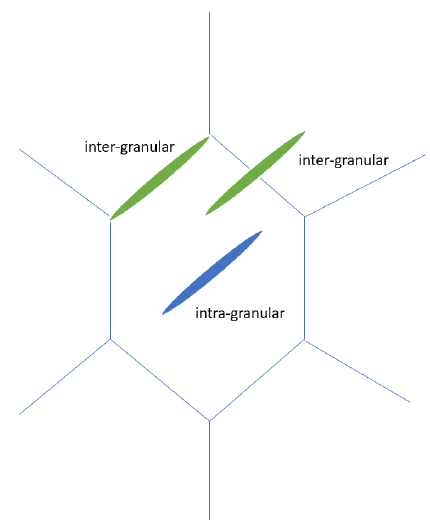
Figure 1. Illustrations of inter-granular (green) and intra-granular (blue) hydrides in a polycrystalline α − Zr matrix. Since we assumed a platelet shape (two axes are symmetric), two forms of inter-granular hydrides, left and right in the figure, can be observed on the 2D